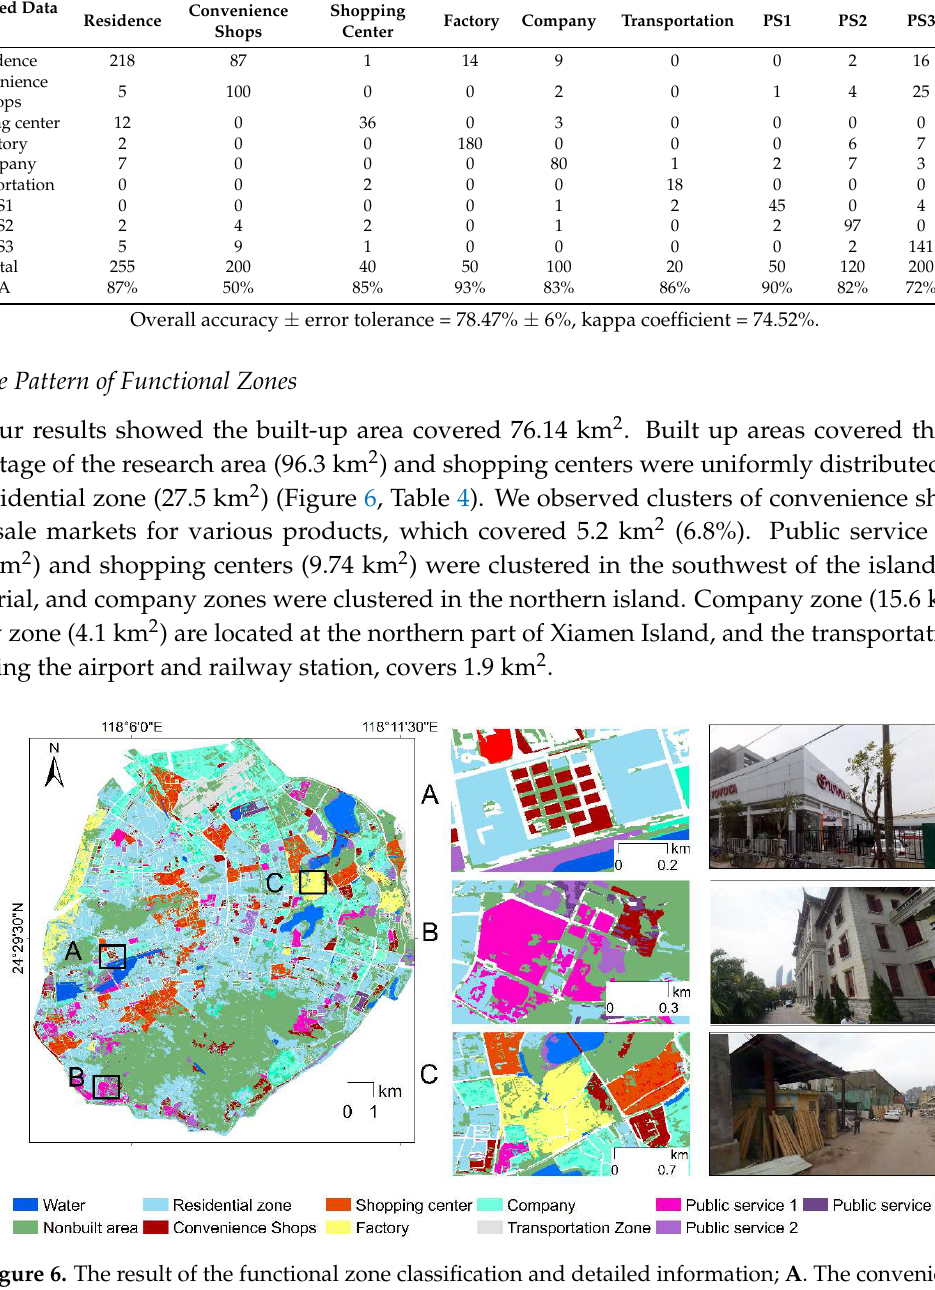
Figure 6. The result of the functional zone classification and detailed information; A . The convenience shop zone: the car sales area. B . The public service zone: the campus of university C . Factory.